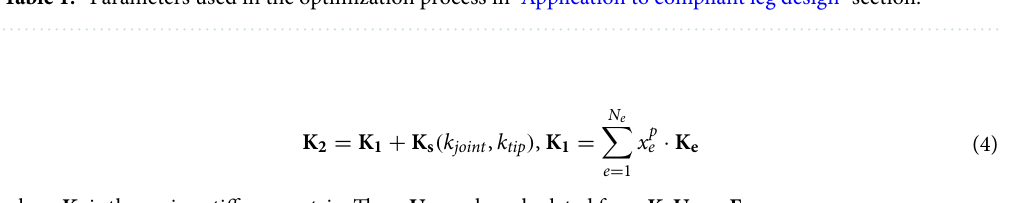
Table 1. Parameters used in the optimization process in “Application to compliant leg design”